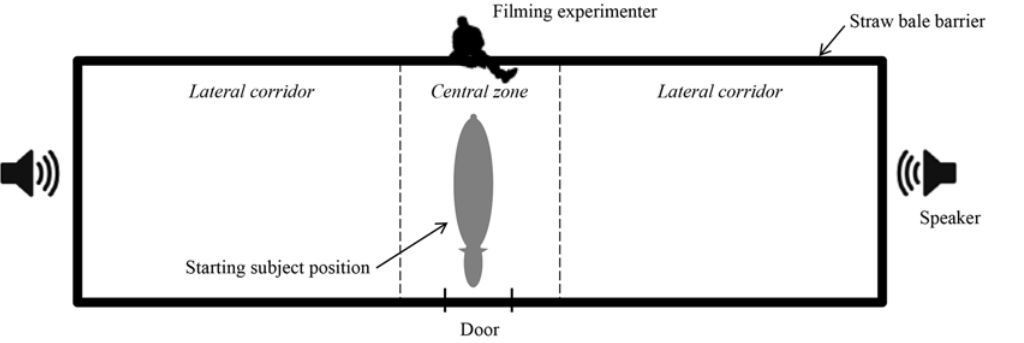
Fig 5. Playback experiment set